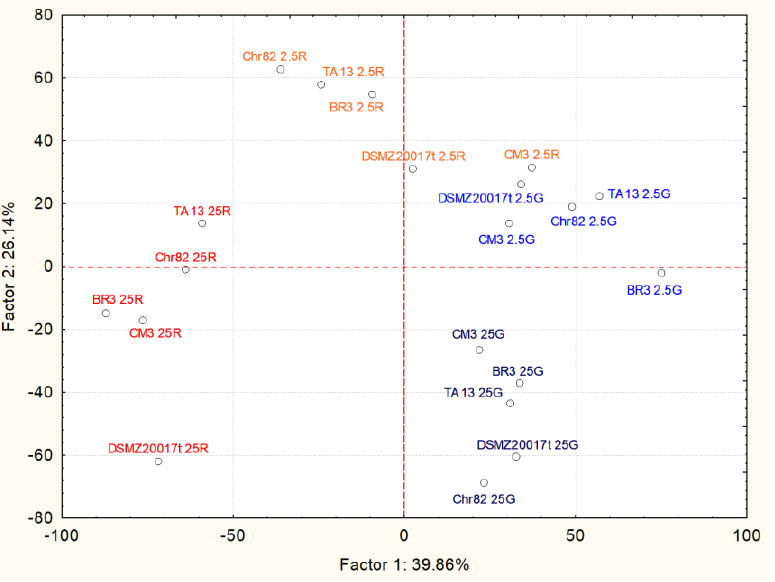
Figure 2. Results of PCA based on covariance matrix of percentages of amino acid variations after 24 h of incubation for the five L. sakei strains in the defined media with different sugar amounts. Projection of case coordinates on the sample score plot of the first two factors, explaining 66% of variability.